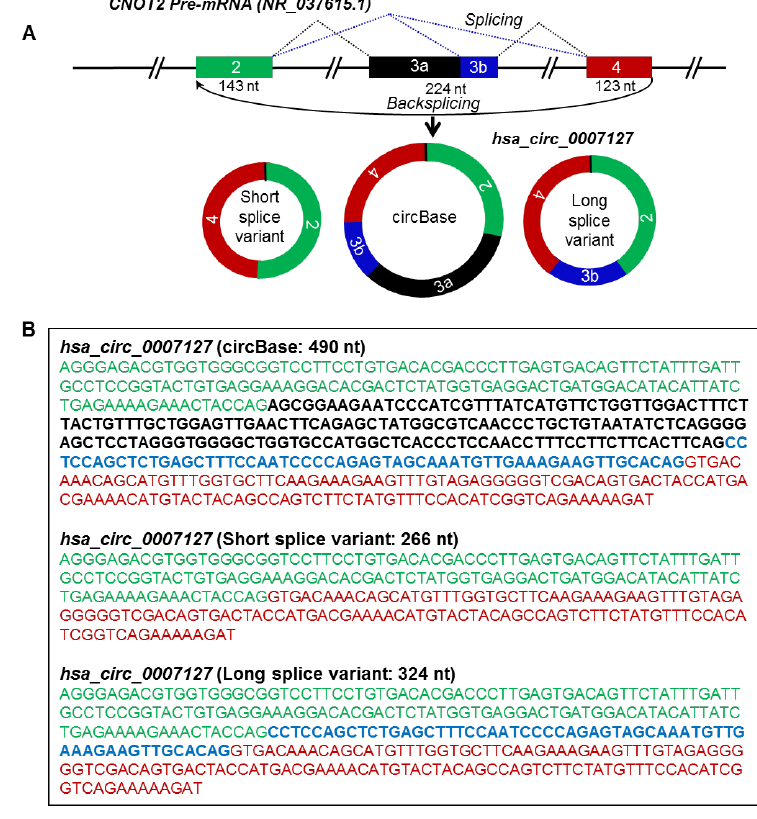
Figure 4. Alternative splicing generates circRNA splice variants. ( A ) Schematic representation of the CNOT2 pre-mRNA and biogenesis of hsa_circ_0007127 splice variants by alternative splicing. Boxes and straight lines represent exons and introns, respectively. The black dotted lines represent splicing, while the blue dotted lines represent alternative splicing. ( B ) Spliced full-length sequences of circBase and splice variants of hsa_circ_0007127. The text color matches the color of the exon box in panel A.